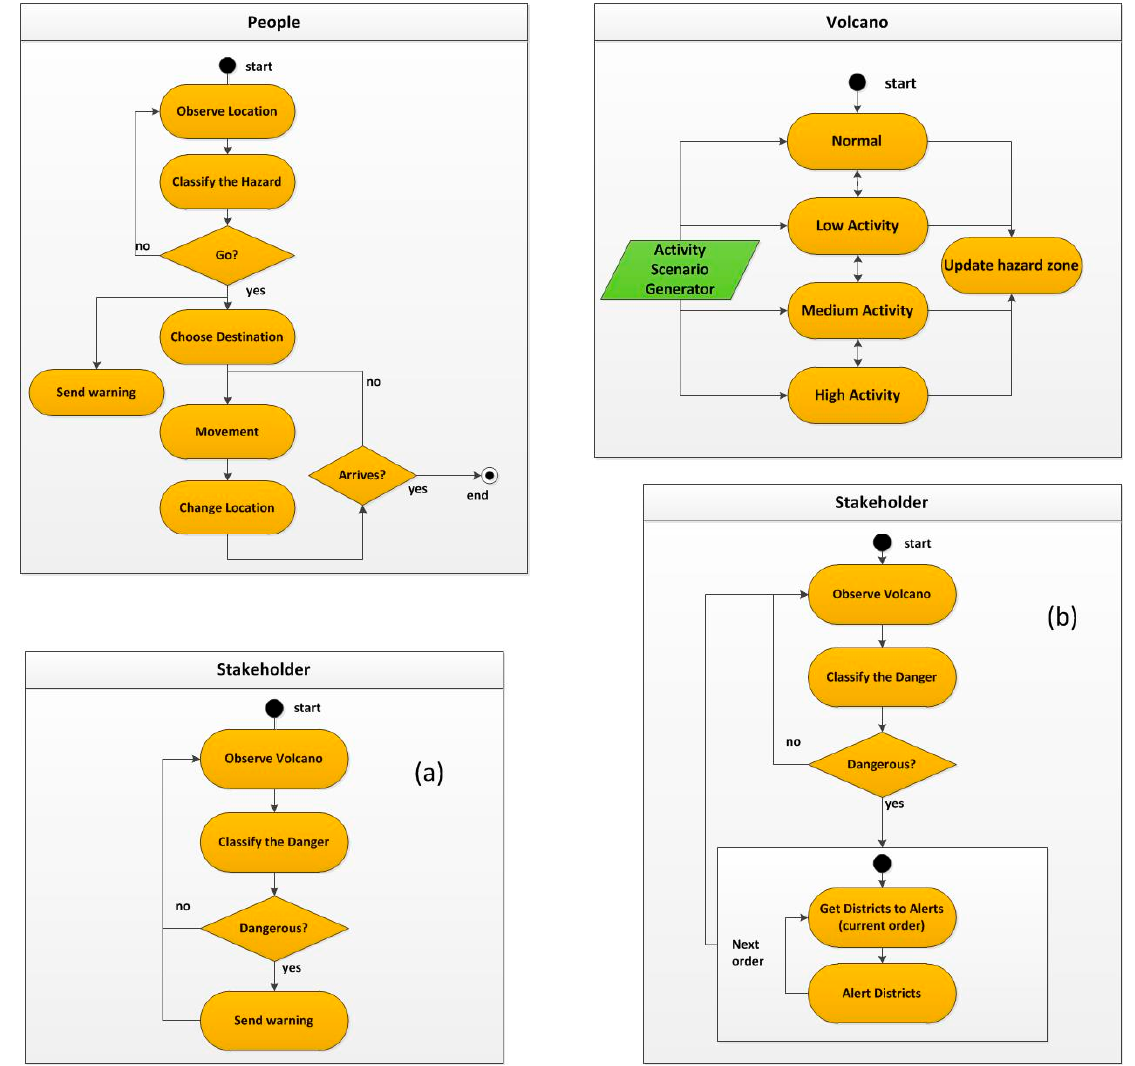
Figure 6. Alerting rule, ( a ) simultaneous scenarios, ( b ) staged scenarios.